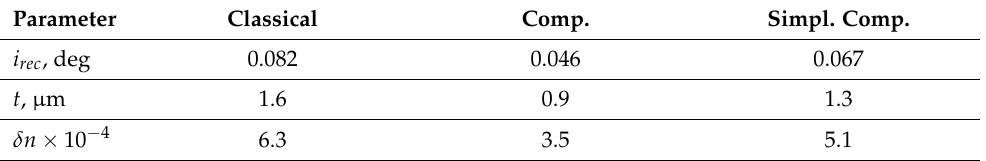
Table 6. Tolerances based on the diffraction efficiency criterion. Parameter